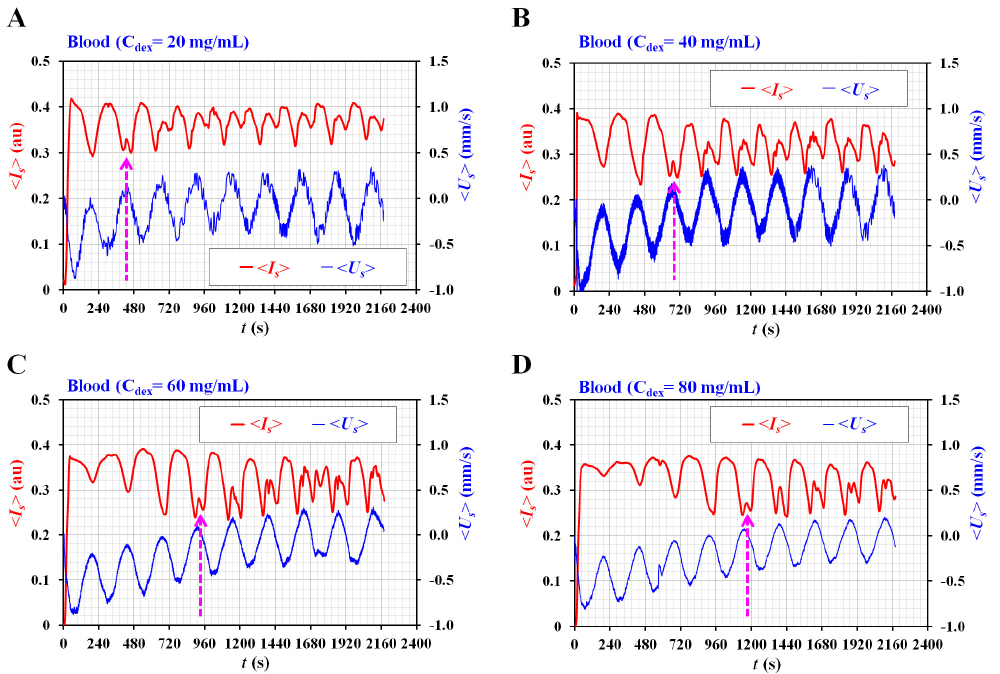
Figure A2. Variations of < I s > and < U s > with respect to concentration of dextran solution (C dex ) (C dex = 20, 40, 60, and 80 mg/mL). ( A ) Temporal variations of < I s > and < U s > for blood (C dex = 20 mg/mL). ( B ) Temporal variations of < I s > and < U s > for blood (C dex = 40 mg/mL). ( C ) Temporal variations of < I s > and < U s > for blood (C dex = 60 mg/mL). ( D ) Temporal variations of < I s > and < U s > for blood (C dex = 80 mg/mL).